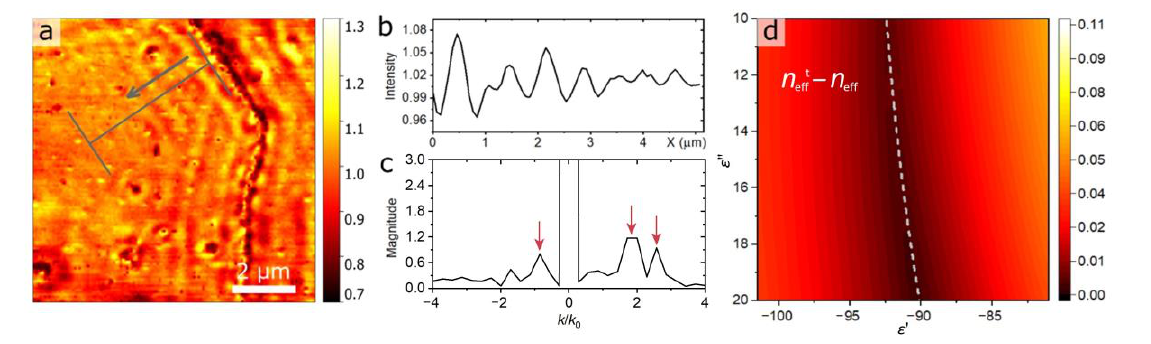
Figure 4. ( a ) s-SNOM amplitude imaging of fringes observed on 10-nm-thick Au film on MoS 2 near the line-crack edge. ( b ) Signal profile line scan of the fringes extracted from ( a ) and averaged over 2.5 μm (gray line in a ). ( c ) FT near-field amplitude of the near-field signal along propagation in ( b ). ( d ) Results of ε ′ and ε ″ range determination by comparison of the calculated effective mode index ( n efft ) with the experimentally determined one.